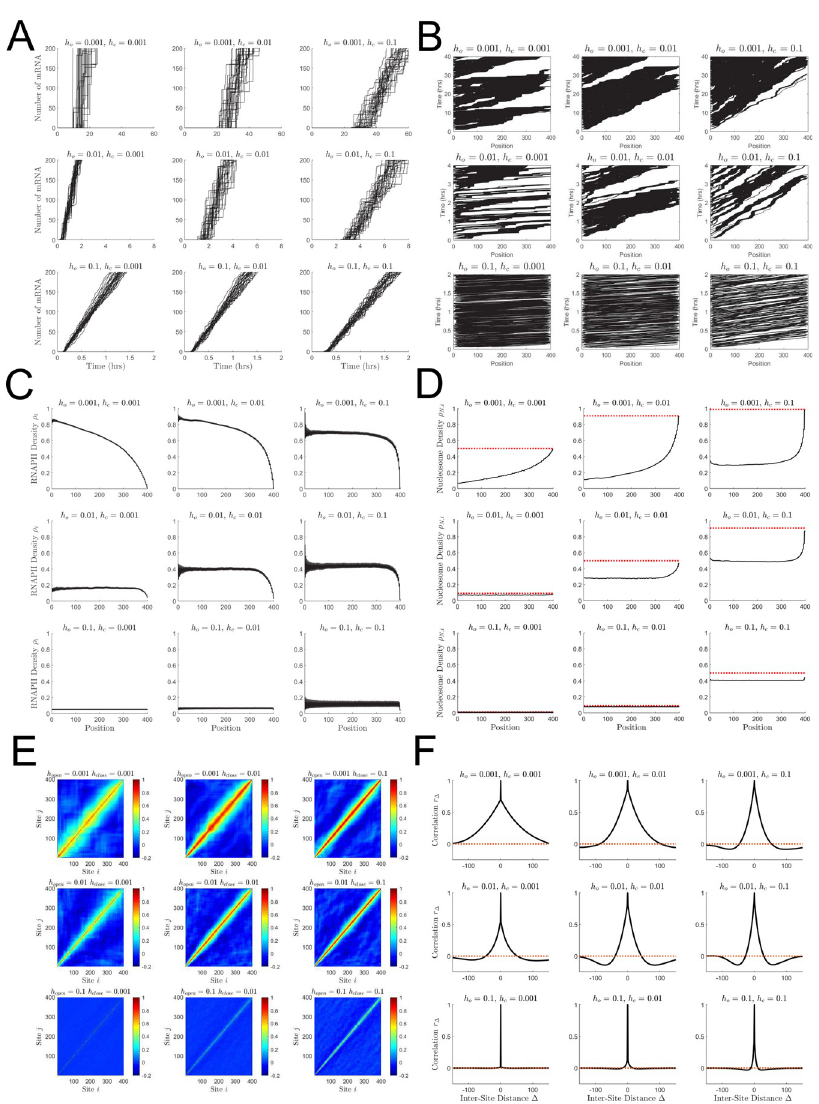
Fig 2. Qualitative behavior of the ddTASEP over a range of representative parameters. All sub-figures are composed of 9 subplots. For all plots, the transcription initiation rate α was set to 0.05, while h o is held constant along is held constant along columns (increasing rows (increasing from 0.001 ! 0.01 ! 0.1 from top to bottom) and while h c from 0.001 ! 0.01 ! 0.1 from left to right). The top right subplot deviates the furthest from the canonical TASEP behavior while the bottom left most closely resembles ideal TASEP behavior. Simulations shown in panels A, C, D and F utilized 4.5 × 10 5 Monte Carlo Steps with 50 replicates. (A) Number of completed mRNAs as a function of time. Notice that the simulation times for the top, middle, and bottom rows are 60, 8, and 2 hours, respectively. (B) Kymographs plotting the position of each RNAPII on the gene (x-axis) as time advances (y-axis). (C) Time averaged RNAPII site density ρ i as a function of position. The wavy density profiles are caused by the fact that the linker sites have a higher average RNAPII occupancy than the neighboring nucleosome sites. (D) Time averaged nucleosome site density ρ N , i (black line) as a function of position (ignoring linker sites). The bulk nucleosome density is anti-correlated with the polymerase density, reaching a maximum at the end points where polymerases are rapidly ejected. The dotted red lines indicate the resting-state nucleosome density prior to transcriptional initiation. (E) Inter-site correlation heatmaps with colors bars ranging from -0.2 to 1. (F) Average inter-site correlation profile ( r Δ , black line) as a function of relative inter-site distance Δ with the dotted red line indicating